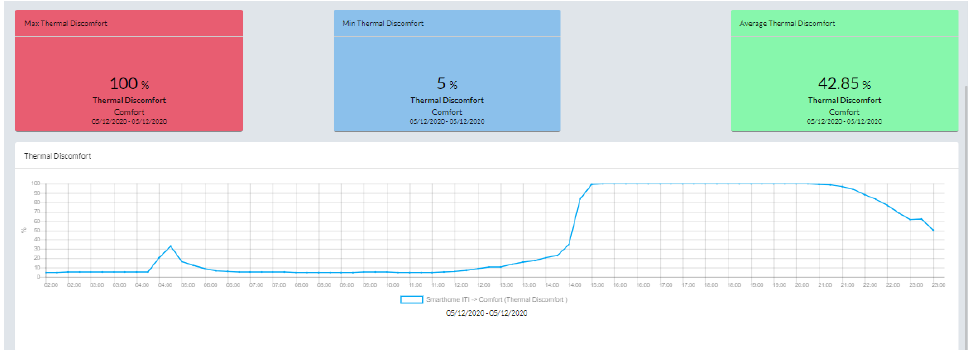
Figure 9. Comfort tool monitoring and real time visualization to the UI.